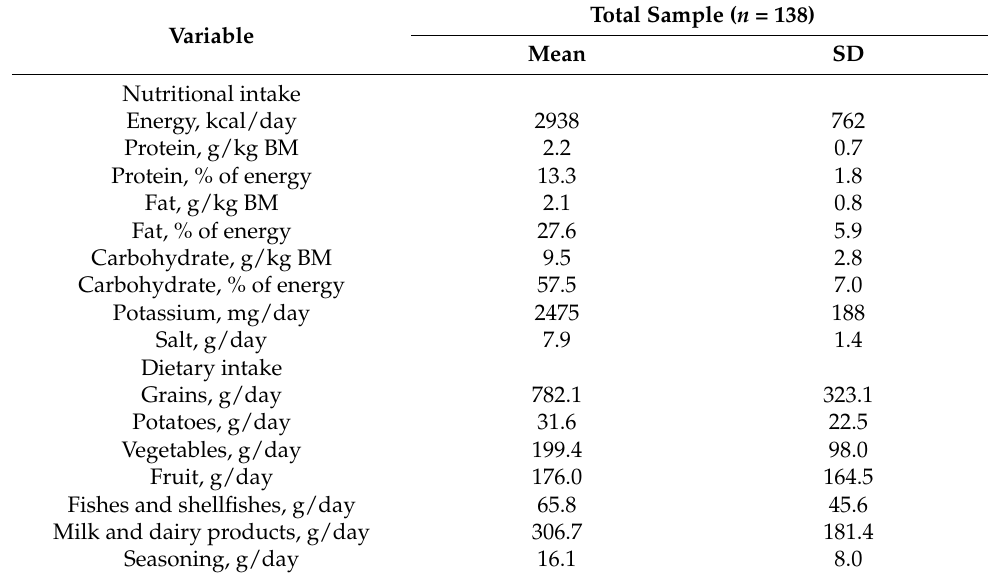
Table 3. Nutritional and dietary intakes of the study participants.